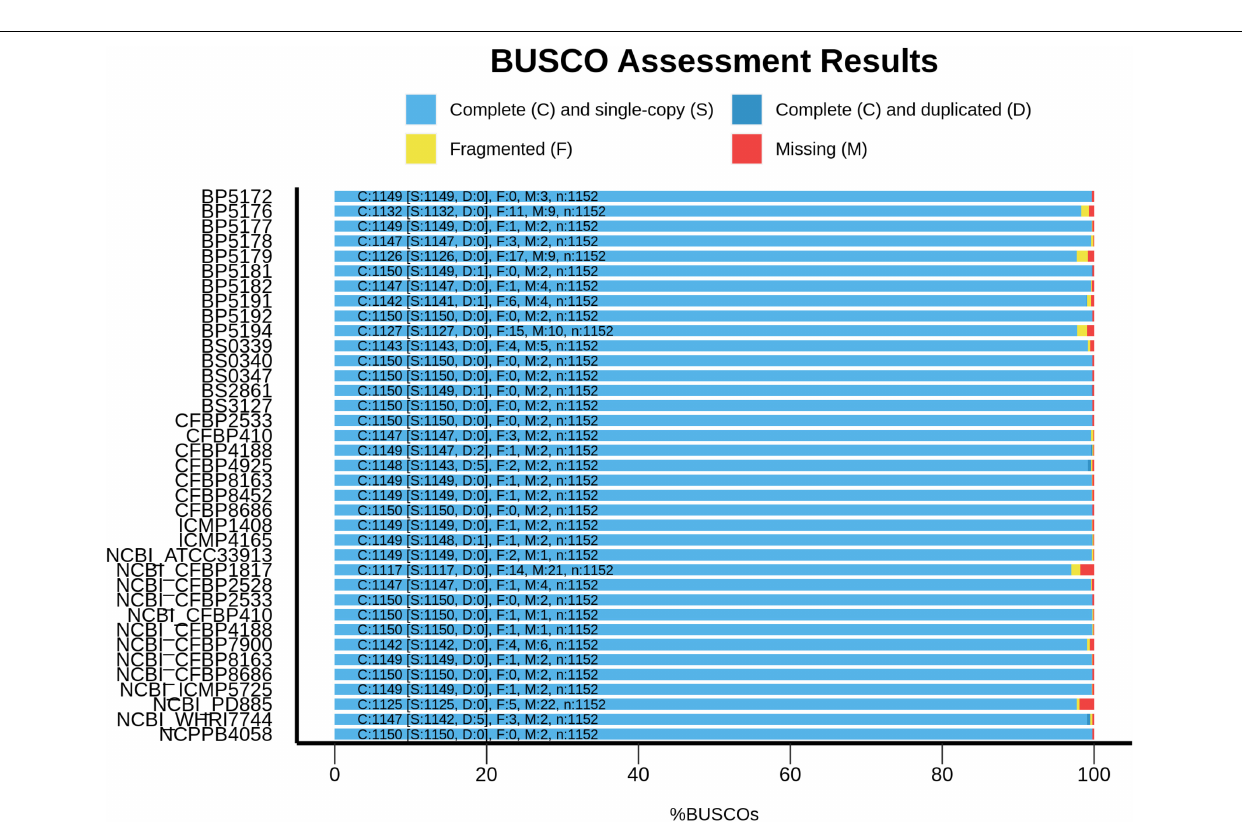
FIGURE 1 | Bioinformatics workflow for comparing whole genome sequences.